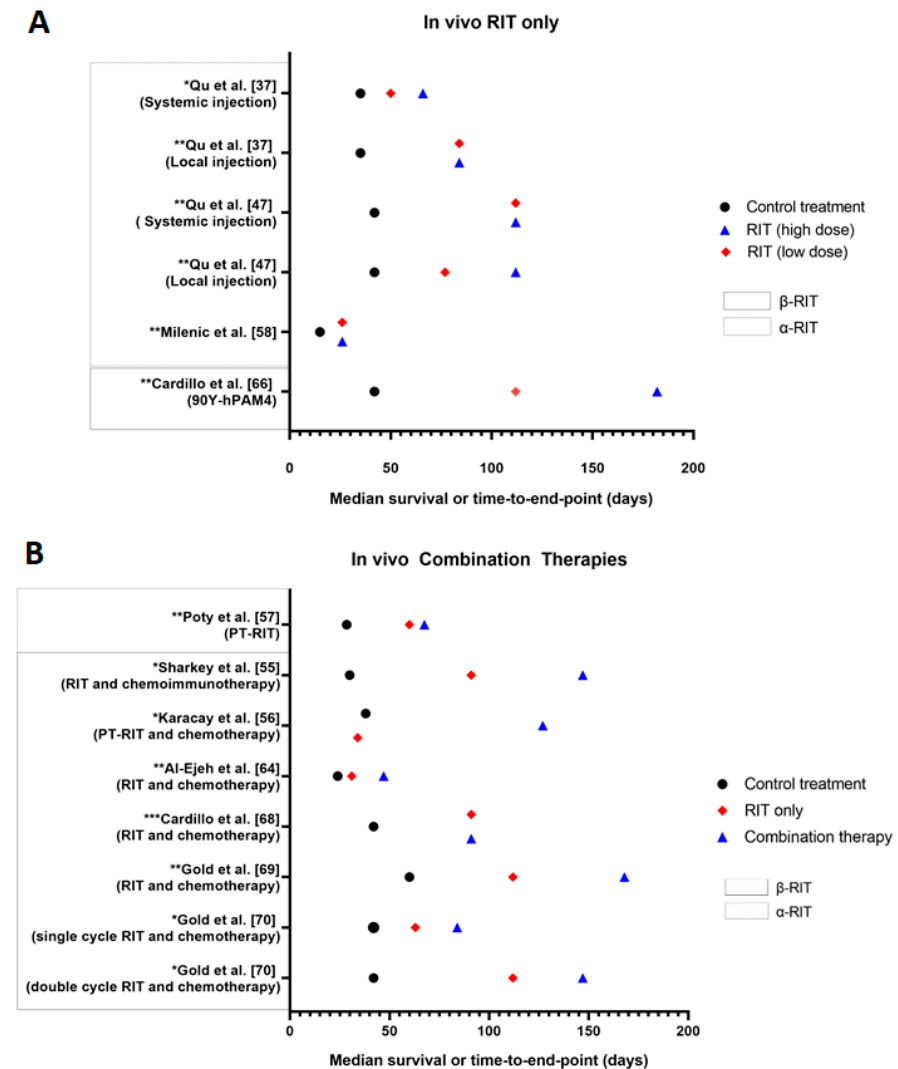
Figure 5. Median survival or time to end point for in vivo studies. A, stand-alone RIT (high and low doses) compared to control treatment (untreated or cold antibody). * p ≤ 0.01 and ** p ≤ 0.001 for high-dose RIT compared to control treatment. B, RIT in combination with other therapeutic agents (including pre-targeting) for the treatment of PDAC compared to untreated controls. * p < 0.05, ** p ≤ 0.001, *** p ≤ 0.0001 for combined therapy compared to control, except for Sharkey et al. [55] and Karacay et al. [56], where p -value compares combination therapy to stand-alone RIT. For Karacay et al. [56], the RIT only data point refers to PT-RIT only. A single representative case is used for studies where multiple experiments were